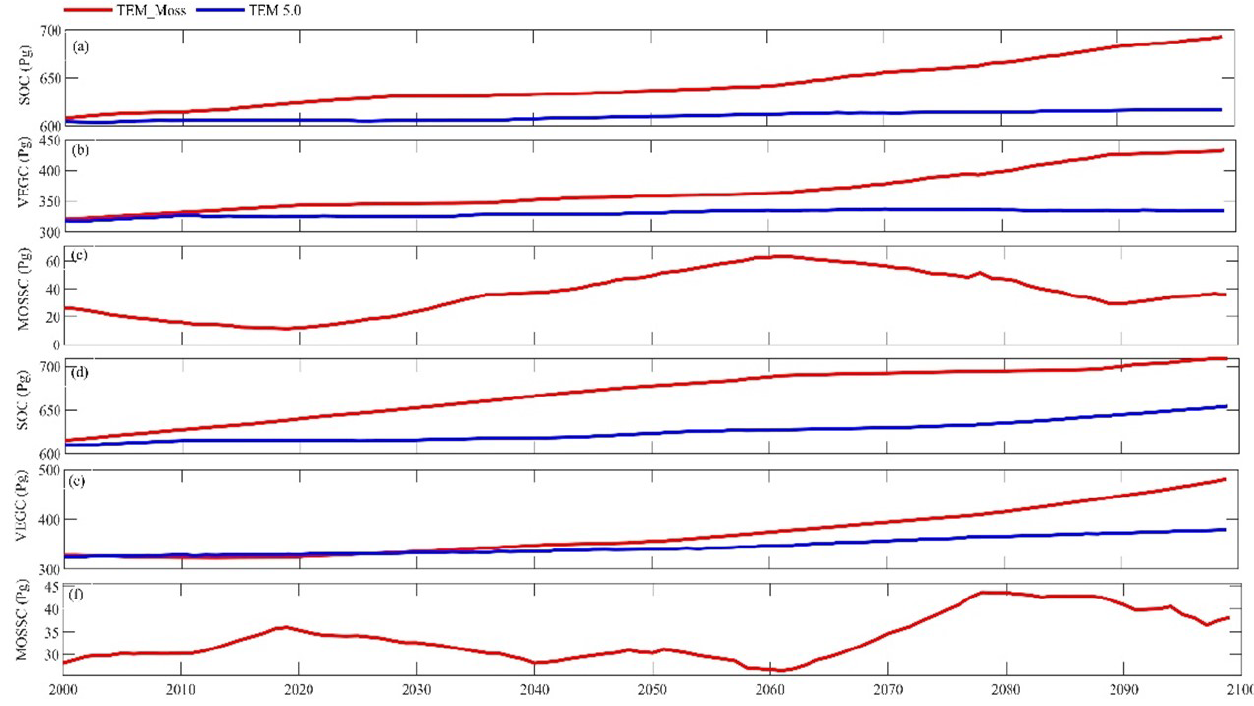
Figure 14. Simulated annual soil organic carbon (SOC, a , d ), vegetation carbon (VEGC, b , e ), and moss carbon (MOSSC, c , f ) during the 21st century by TEM_Moss and TEM 5.0 under the RCP2.6 scenario (a–c) and RCP8.5 scenario (d–f)